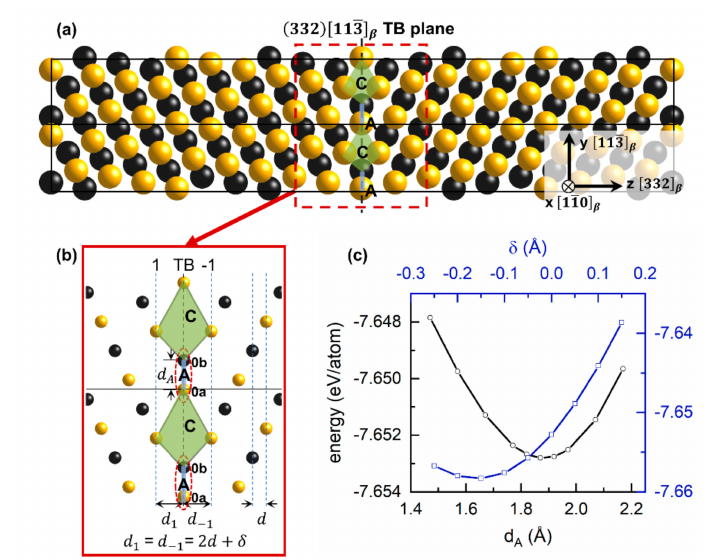
(cid:16) (cid:17) 110 planes. Black dashed line